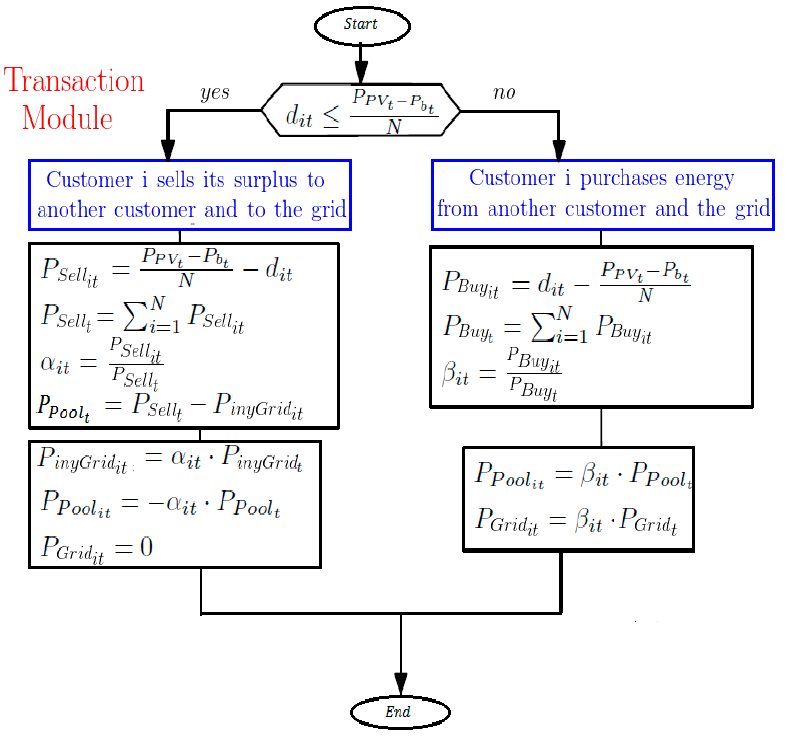
Figure 2. Flow diagram to supply renewable energy under equality criteria.